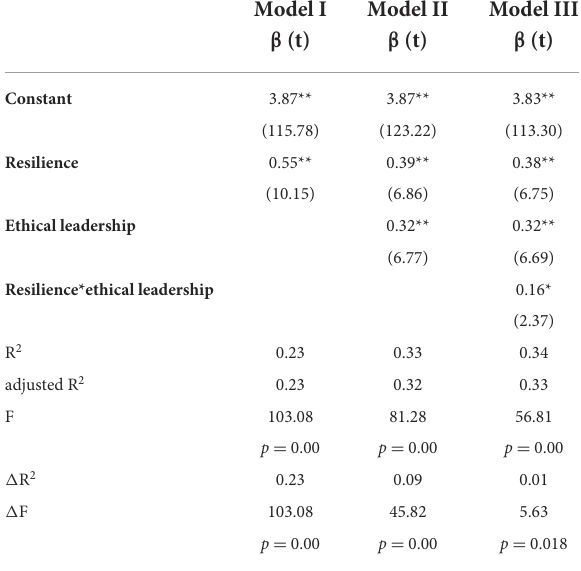
TABLE 4 Moderated regression